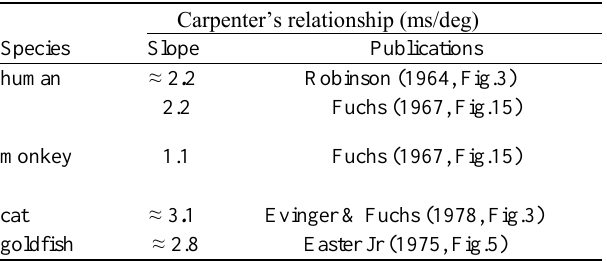
Table 2. The linear regression slopes of Carpenter’s relation- ship of diverse animal species. The slopes are either the re- ported results (averaged if multiple) or our approximations based on the figures (only considering the results of saccades ≤ 20 °) in the